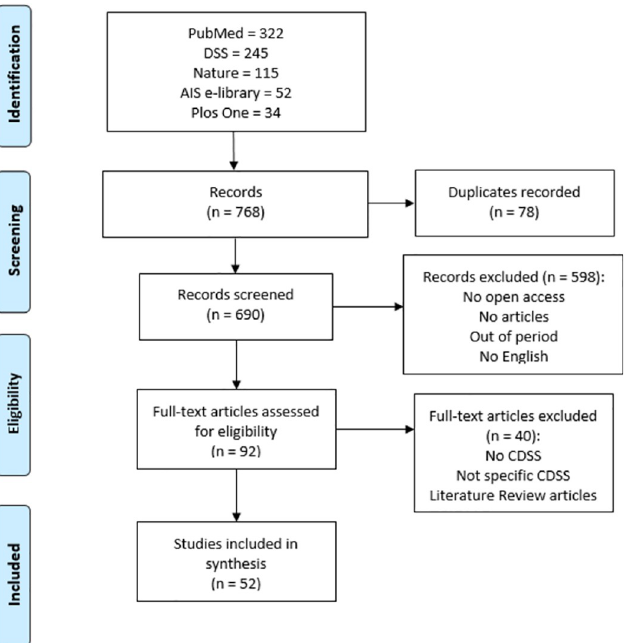
Fig 2. Flow diagram of study selection for systematic